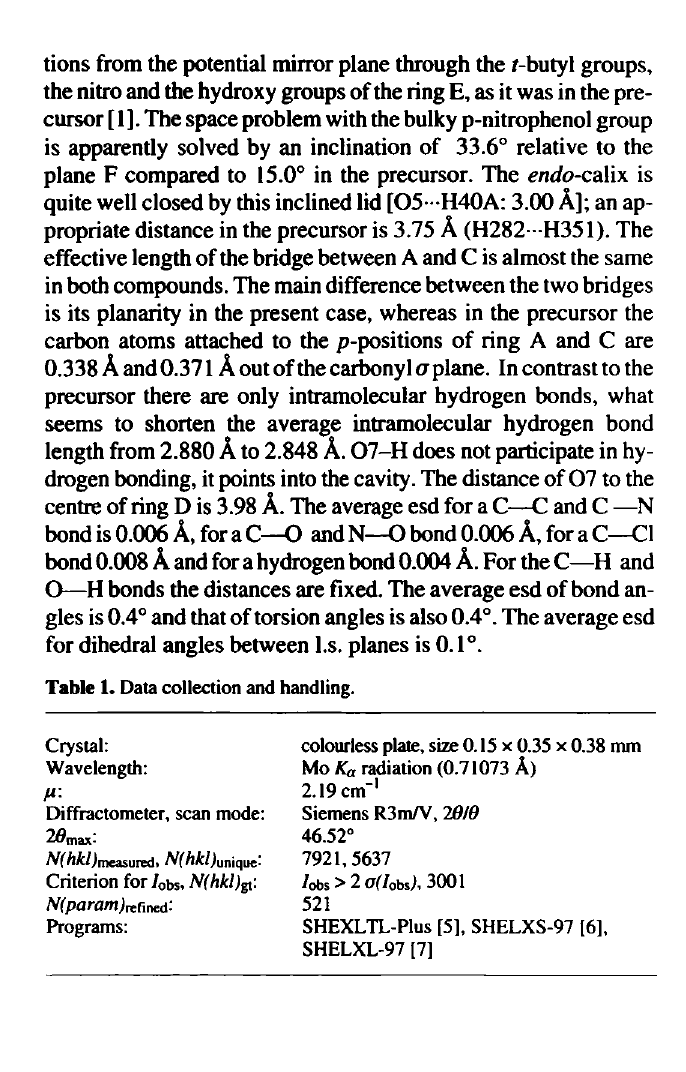
Table 1. Data collection and